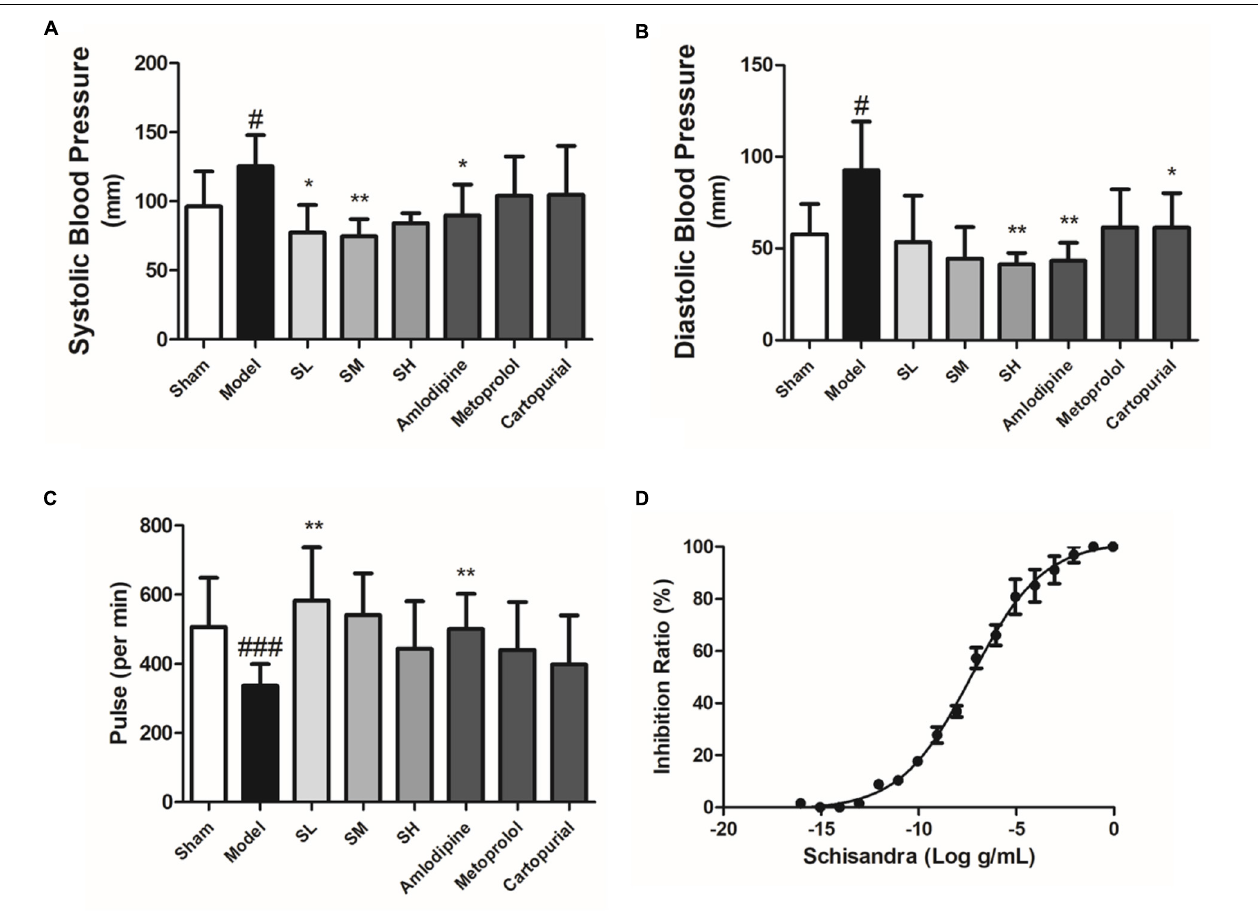
FIGURE 8 | The blood pressure, heart rate and vasodilation ratio of Schisandra . Systolic blood pressure (A) , diastolic pressure (B), and pulse (C) was tested 30 min after the last corresponding drug was given. (D) The vasodilation effect of Schisandra . The rat main artery was cut into 3 mm artery rings and were activated through 1 µ M Adr. All data are shown as the mean ± SD. # P < 0.05, ### P < 0.001 vs. Sham group; ∗ P < 0.05, ∗∗ P < 0.01 vs. Model group.